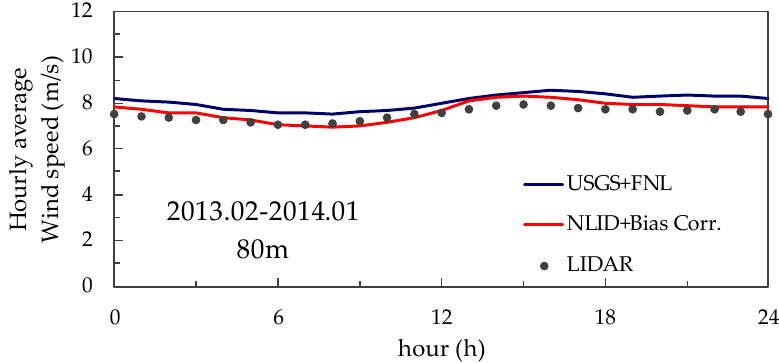
Figure 17. Diurnal variation of hourly averaged wind speed at the hub height of 80 m.